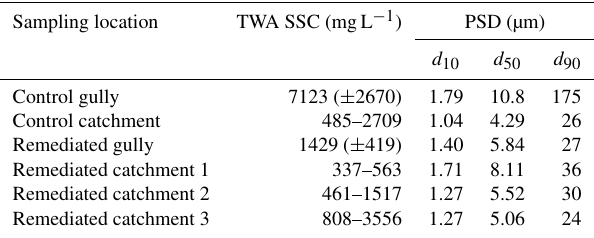
Table 3. Time-weighted average suspended sediment concentration and particle size distribution data of samples collected, using PASS samplers, from the remediated and control gullies during the 2017– 2018 and 2018–2019 wet seasons. Note that the catchment samples ( n = 2 per sampling location) were only collected during the 2018– 2019 wet